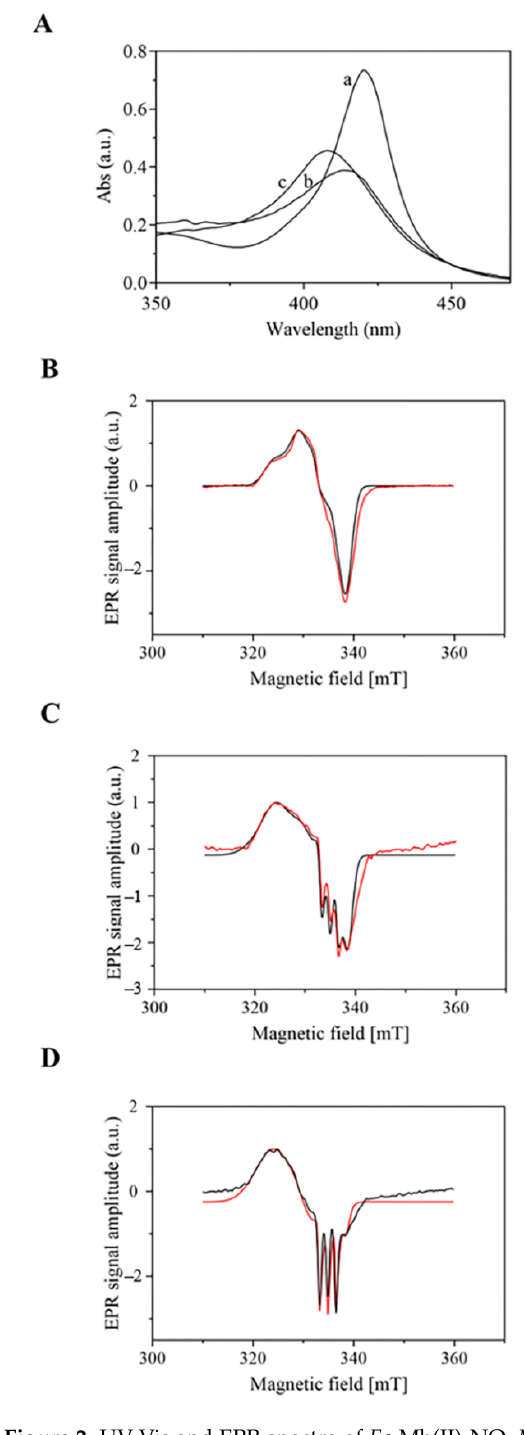
Figure 2. UV-Vis and EPR spectra of Ec -Mb(II)-NO, Mt -Nb(II)-NO, and Hs -Nb(II)-NO Nb at pH 7.0. ( A ) UV-Vis spectra of Ec -Mb(II)-NO (trace a), Mt -Nb(II)-NO (trace b), and Hs -Nb(II)-NO (trace c). ( B ) EPR spectra of Ec -Mb(II)-NO with following populations percentages (0.32 SysA , 0.68 SysR and 0.0 Sys5C ). ( C ) EPR spectra of Mt -Nb(II)-NO with following populations percentages (0.15 SysA , 0.30 SysR and 0.55 Sys5C ). ( D ) EPR spectra of Hs -Nb(II)-NO following populations percentages (0.04 SysA , 0.08 SysR and 0.88 Sys5C ). In the EPR spectra, the experimental spectrum is showed in red while the simulated spectra in black.